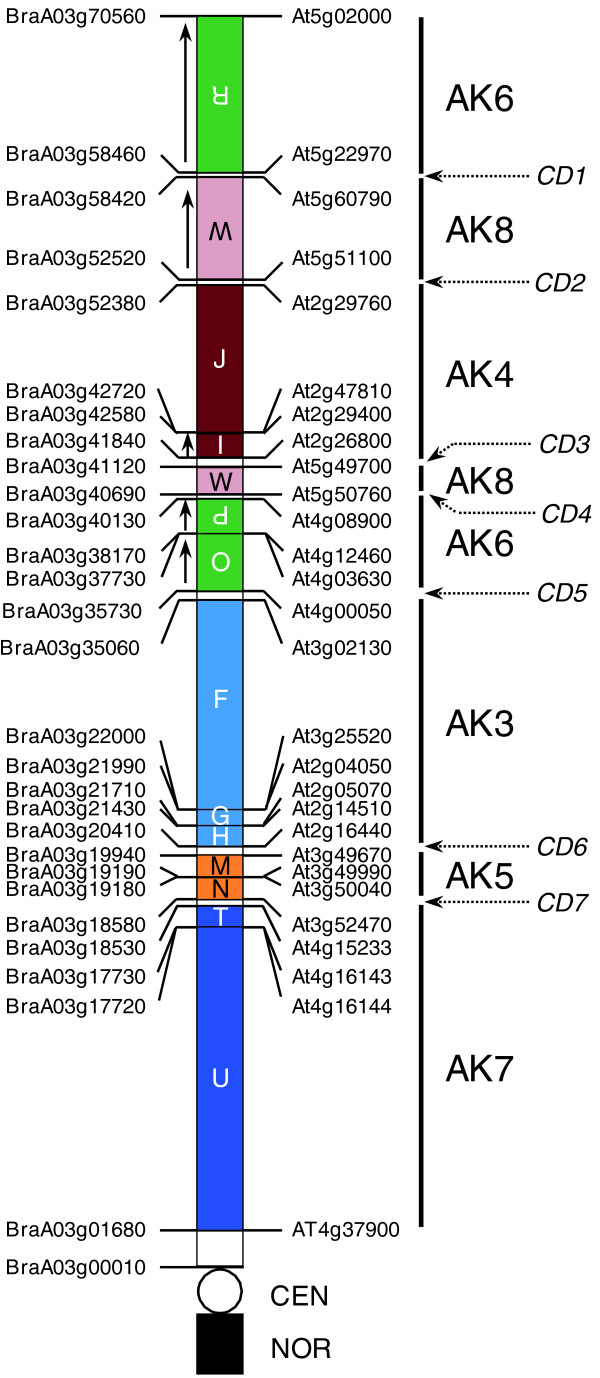
Genome building blocks and block boundaries of the ancestral karyotype mapped onto B. rapa chromosome A3. The position of AK genome building blocks in chromosome A3 was defined by a comparison of B. rapa-A. thaliana syntenic relationships and the A. thaliana-AK mapping results [20,29]. AK segments are labeled and oriented by arrows. Putative orthologs delineating the boundaries of recombination events are designated. CDs between AK blocks are indicated by dotted arrows. CEN, centromere.